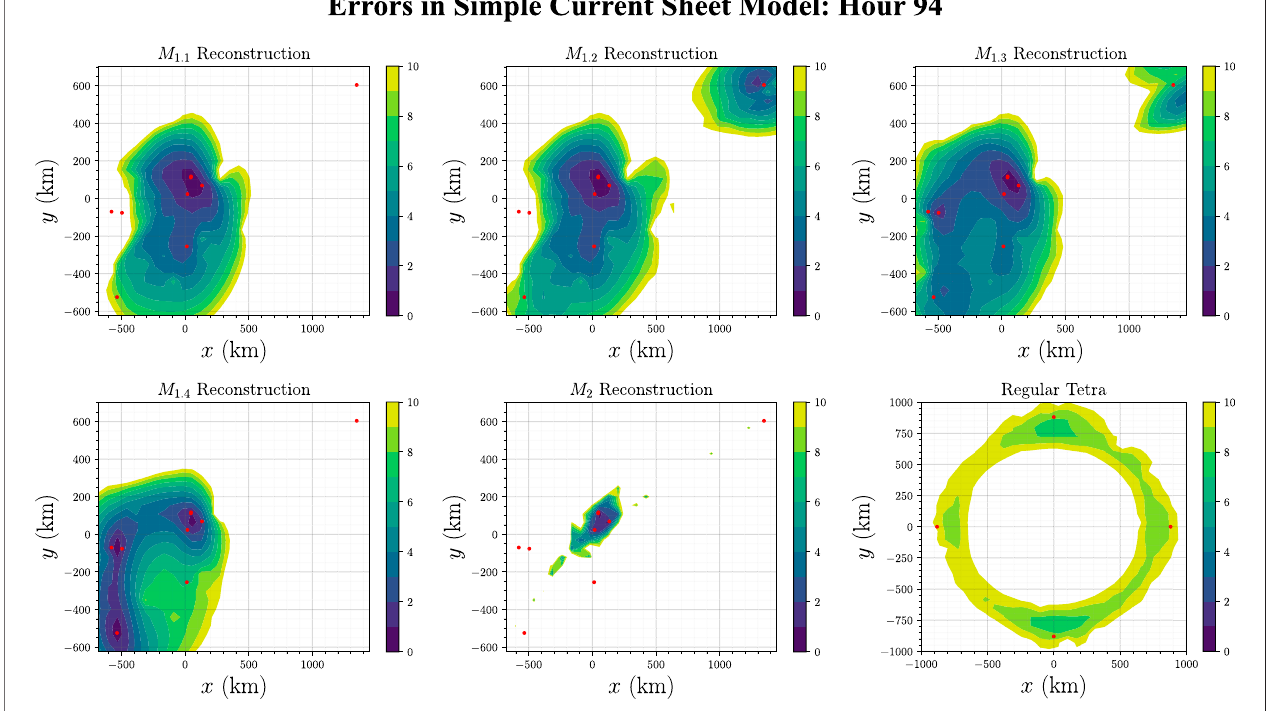
FIGURE 4 | Computation error (de fi ned in Eq. 7 ) at all points on the z (cid:1) 0 plane of the simple current sheet model, using the swarm con fi guration at hour 94 of the HelioSwarm DRM using fi rst-order methods M 1,1 , M 1,2 , M 1,3 and M 1,4 , the second-order method, M 2 and a single regular tetrahedron. The red points represent the spacecraft locations. Areas in white either have a reconstruction error above 10 % , or have no tetrahedron satisfying reconstruction method condition, resulting in no reconstructed fi eld values.